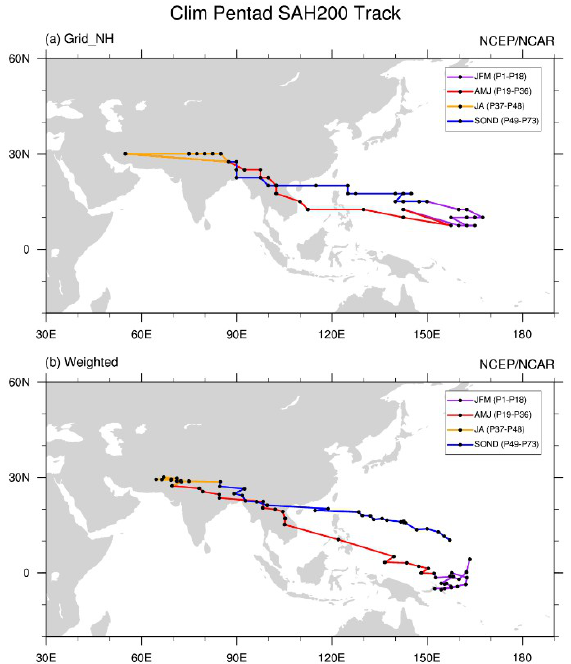
Figure 1. The climatological SAH track from Pentad 1 to Pentad 73. Black dots indicate ( a ) the maximum center of the SAH and ( b ) the gravity center of the SAH. Purple, red, orange, and blue lines indicate the track of the SAH during January–March, April–June, July–August, and September– December,